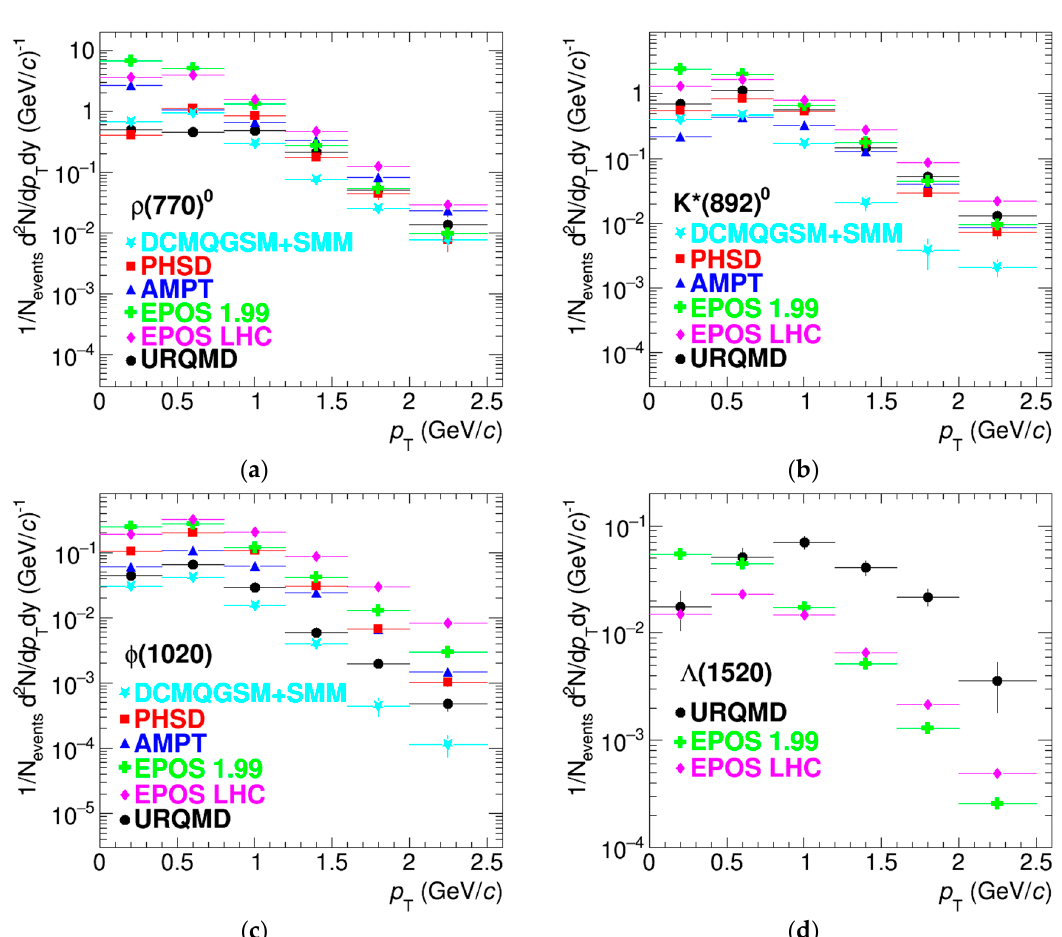
Figure 2. p T ‐ differential production spectra estimated for ρ (770) 0 ( a ), K*(892) 0 ( b ), ϕ (1020) ( c ) and Λ (1520) ( d ) resonances in Au+Au collisions at √ s NN = 9 GeV using different event generators referenced in the text. Statistical uncertainties are shown with error bars. Systematic uncertainties constitute ~10% and are not shown for better visibility.